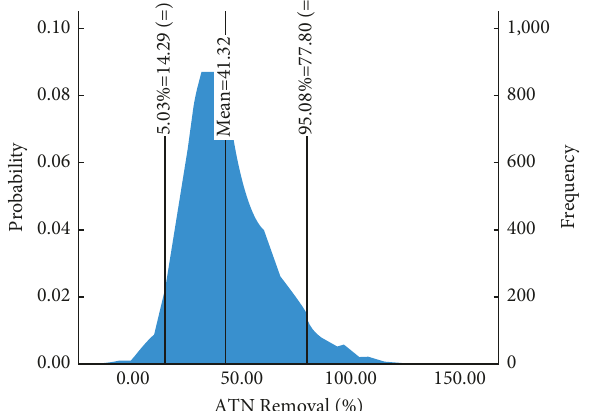
Figure 3: Probability distribution of Monte Carlo simulation output for ATN